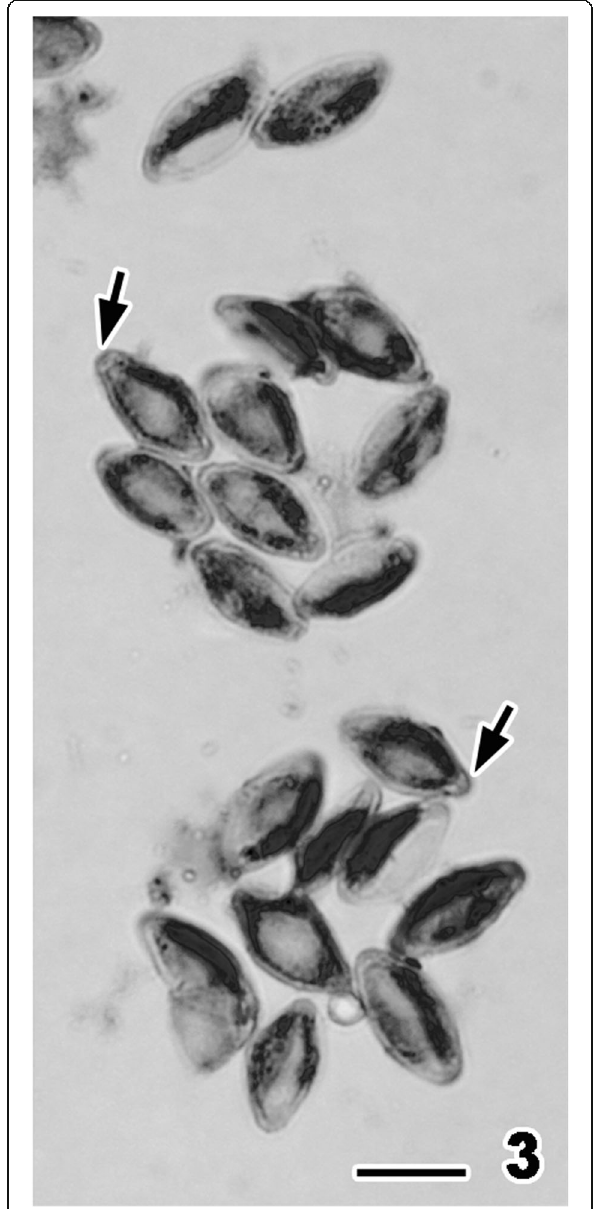
Fig. 3 Giemsa-stained oocysts of Mattesia dispora from Ephestia kuehniella . Giemsa-stained oocysts having polar plugs at each cell pole (arrows). Bars, 10 μ m